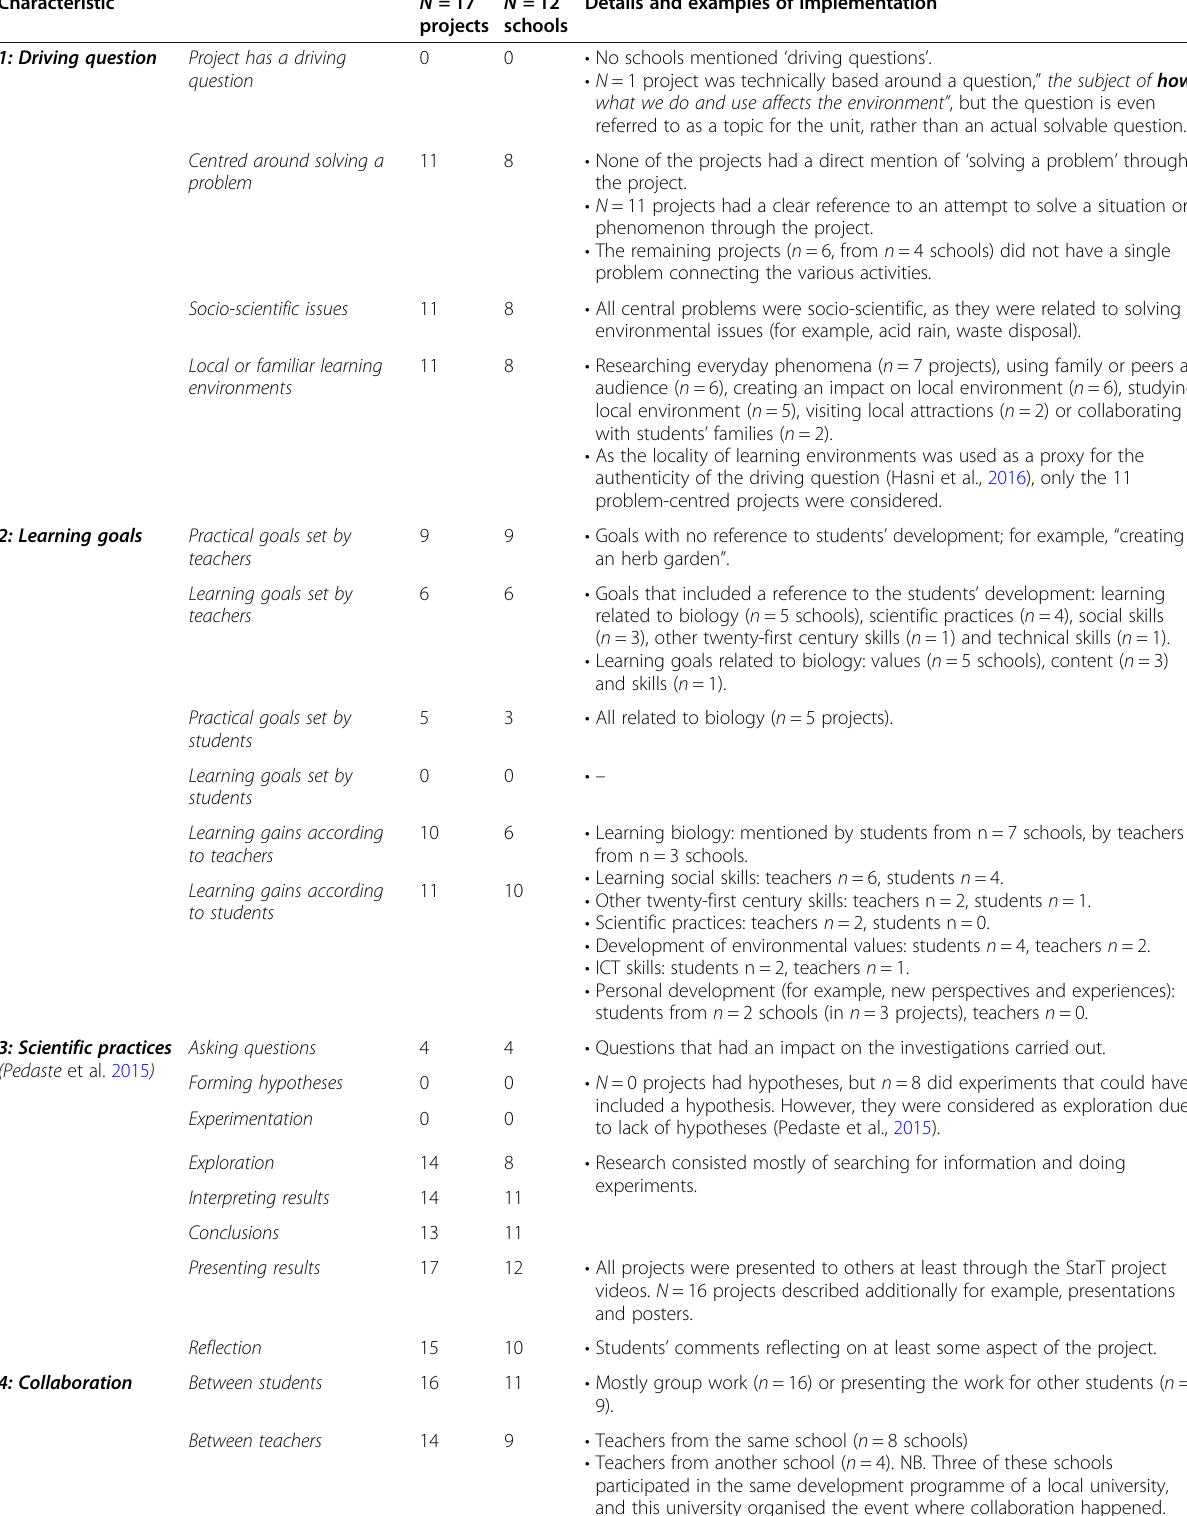
Table 6 Visibility of key characteristics and their implementation in practice in the PBL units Characteristic N = 17